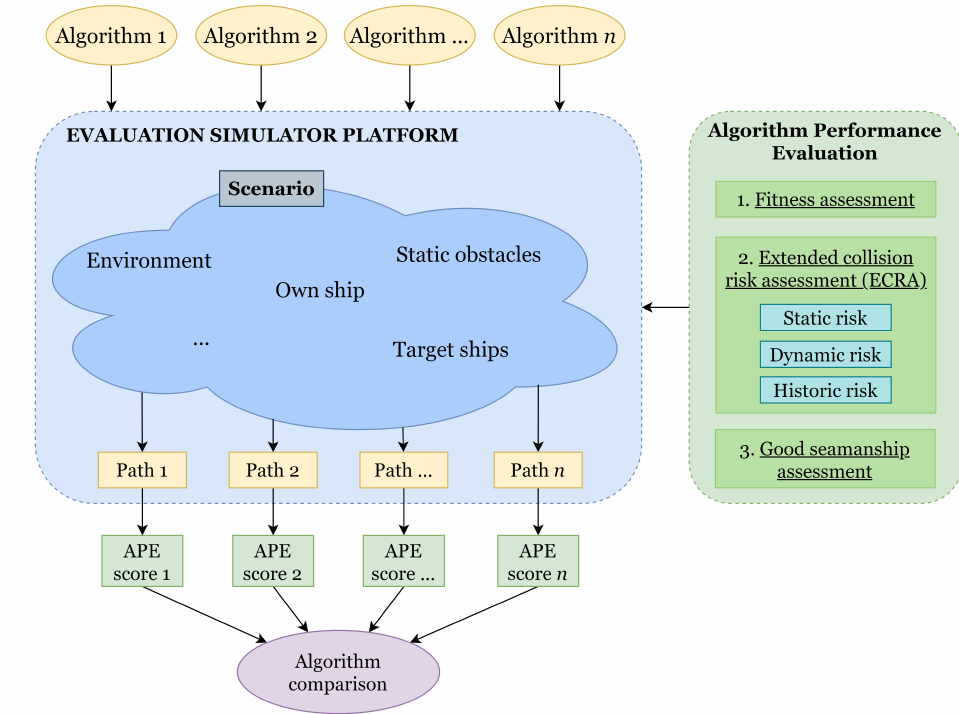
Figure 4. Structure of the evaluation simulator platform (ESP), adapted from Vagale et al. [3].